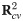
Sensitivity of the Rcv2 (solid line) and correlation (dashed line) to the choice of the regularization coefficient.Simulations come from Experiment 2 with a true signal strength of s = 0.2 and a noise variance of 1. For this combination the optimal regularization coefficient is s-1σε2 (dashed vertical line). The correlation criterion is generally robust against non-optimal choice of regularization coefficient.